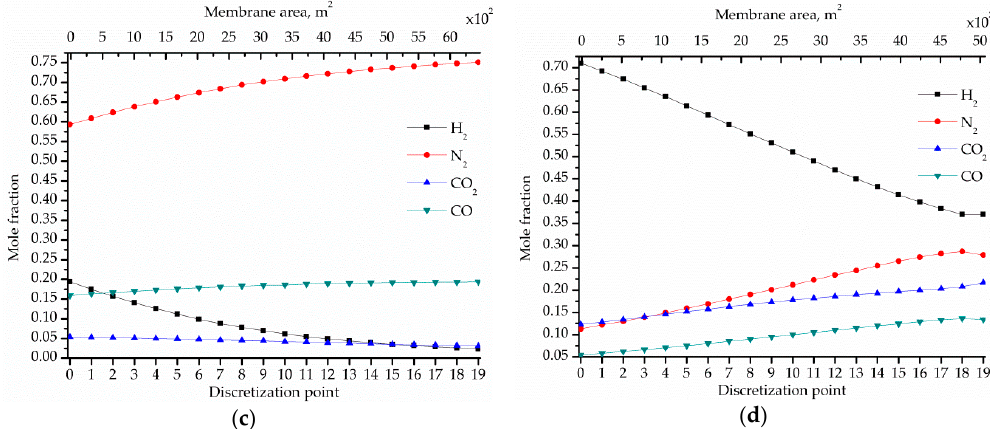
Figure 9. Optimal mole fraction profiles of the components in the membrane modules obtained in solution SUBOPT2, in which the driving force for permeation is created by combining compression and vacuum and the expander is included for power recovery: ( a ) permeate in MS1; ( b ) permeate in MS2; ( c ) retentate in MS1; ( d ) retentate in MS2.